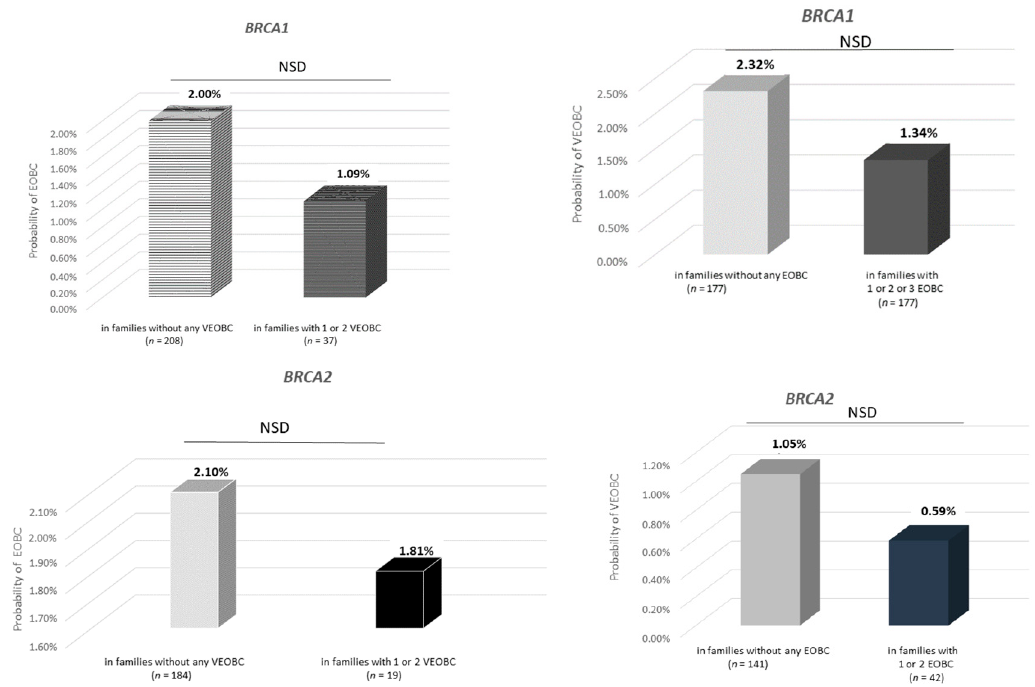
Figure 5. Probability of VEO-BC by number of relatives in the family with BC diagnosed between age 31 and 35. VEO-BC: diagnosed ≤ 30 years old. EO-BC: early-onset BC (diagnosed between age 31 and 35 years). n = number of families. NSD: non-significant difference.